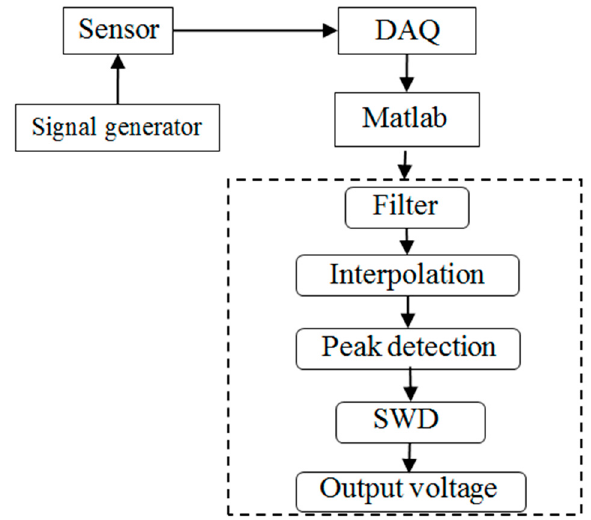
Figure 3. Measurement data processing process. SWD: stationary wavelet decomposition. DAQ: data acquisition.